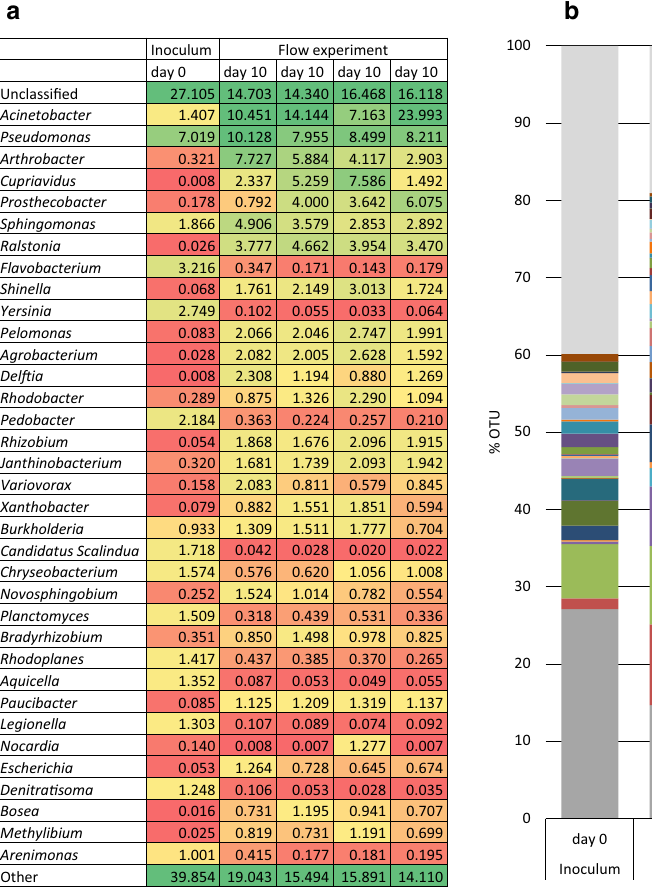
Fig. 3 Bacterial consortium composition (genus level) in soil samples analysed by 16S rRNA amplicon sequencing, in four parallel and replicate flow cells with the same environmental conditions (pH 8, 30 °C), same carbon source (cellulose), same inoculum, and same biofilm harvest time‑point (after 10 days). a Heat map presenting the abundance of dominating genera. b Consortium composition of the most dominating genera. “Other” is the sum of all classified genera with individual abundancies below 1% in all samples. “Unclassified” includes sequences classified at higher taxonomic levels, but where no genus information could be